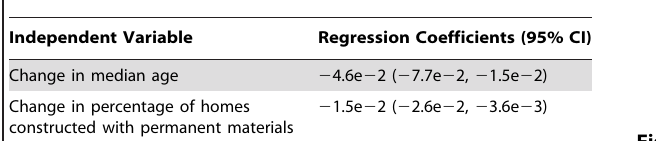
Table 2. Results of univariate linear regression of change in the force of infection from 1985 to 2005 estimated using model 4 on demographic, socioeconomic, and climatic characteristics of provinces.